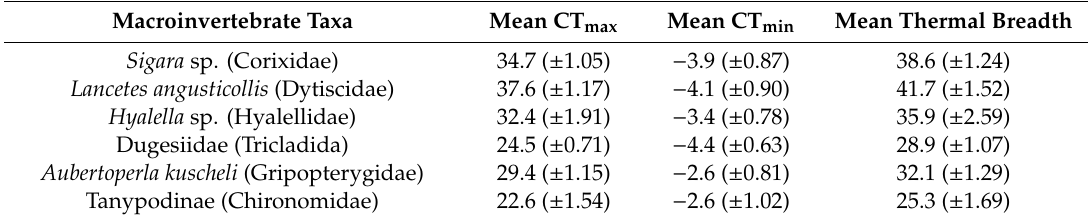
Figure 5. Critical thermal limits and thermal ranges of the studied taxa across the altitudinal gradient of the Róbalo watershed; ( a ) CTmax declined with increasing elevation while CTmin varied little; ( b )